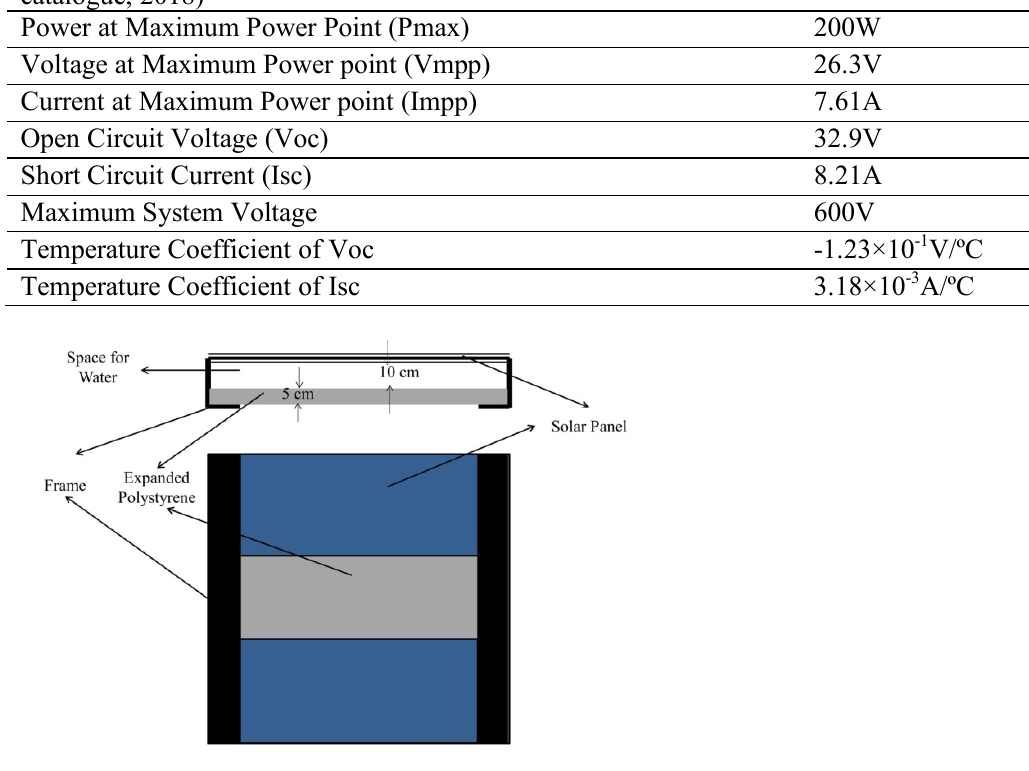
Figure 4 . schematic of floating photovoltaic